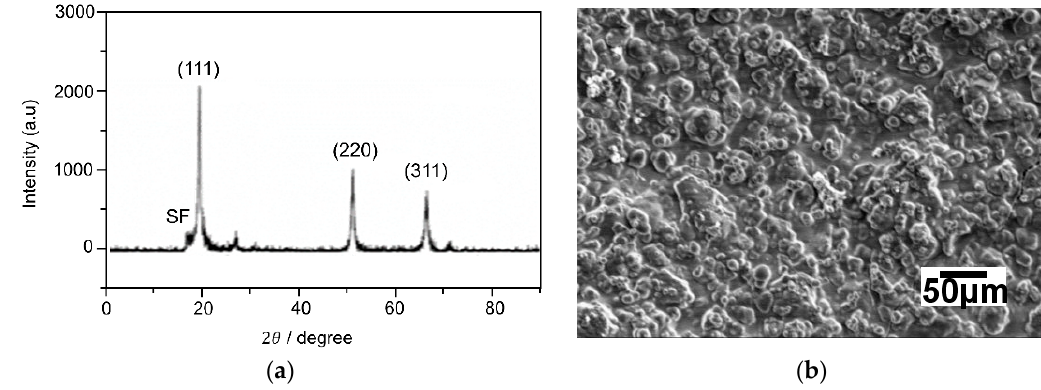
Figure 1. Structure of the inner SiC coating: ( a ) XRD pattern; ( b ) surface SEM image.